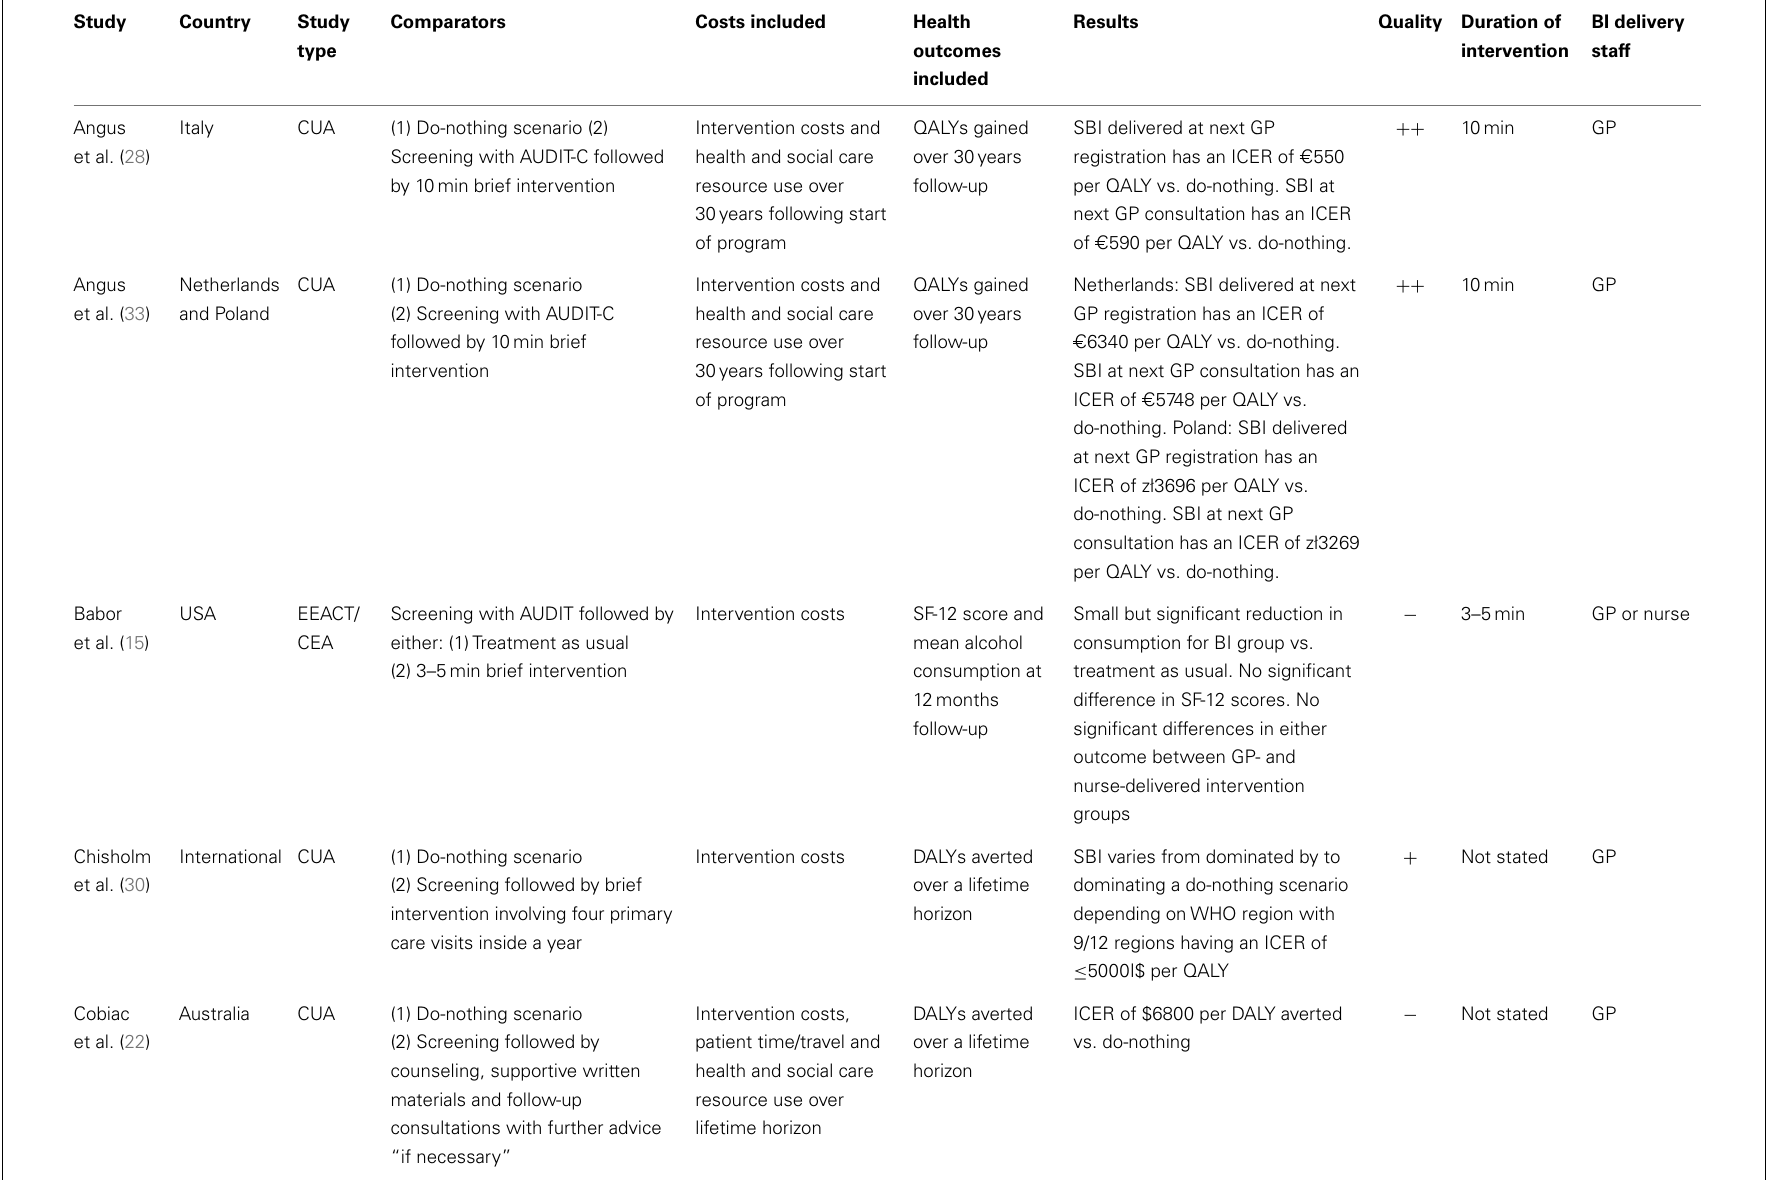
Table 1 | Characteristics of included studies